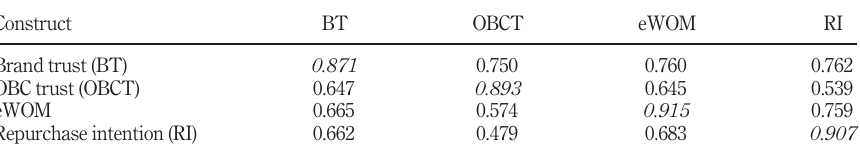
Table 2. Discriminant validity